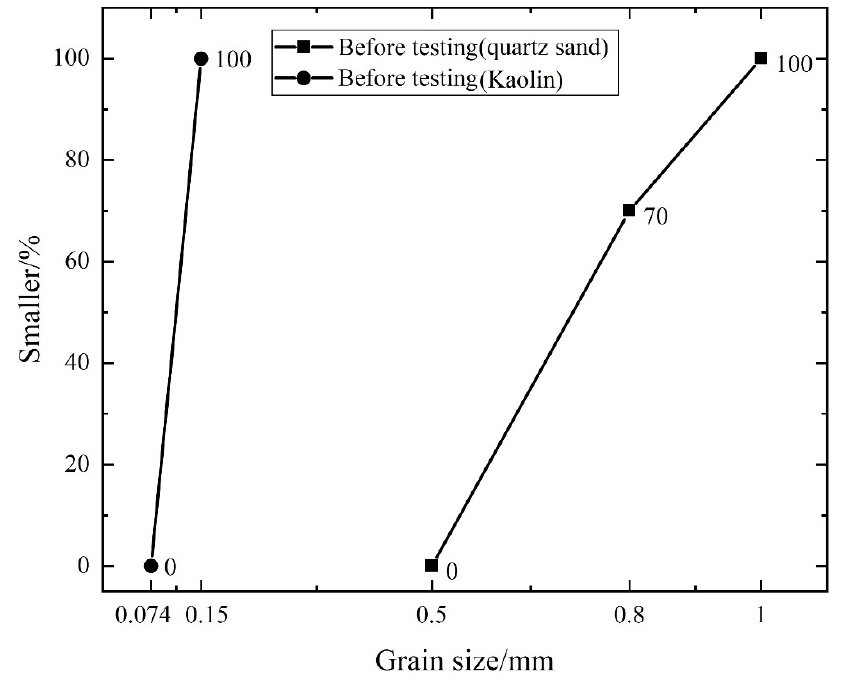
Figure 4. Particle size distribution curves of quartz sand and Kaolin before impact.